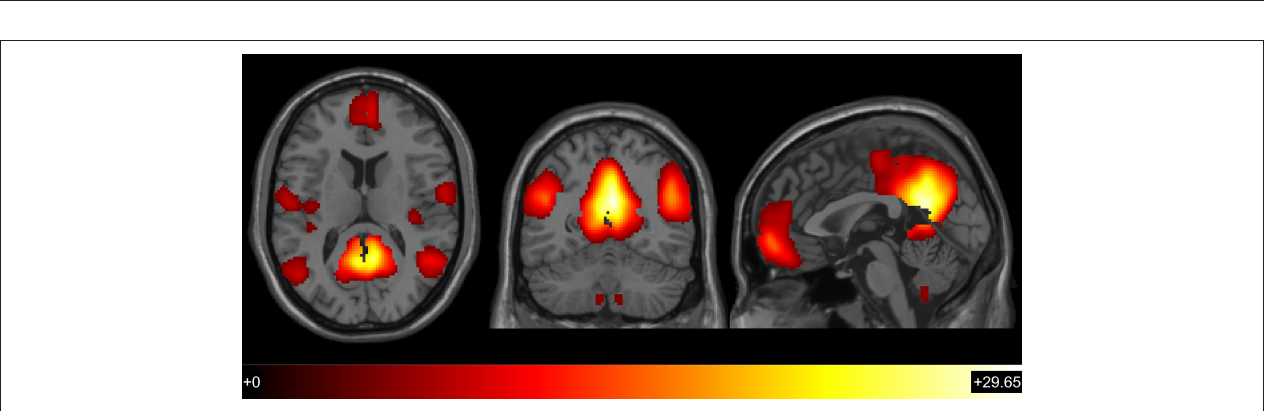
FIGURE 3 | association and cool colors represent a negative association. A positive association between GDS score and metabolic dysfunction or obesity or glucose dysmetabolism was observed in the younger individuals of our sample and became negative at the older ages (B,D,F) . The association between GDS score and lipids imbalance was always positive across the age range (H) . No association between GDS score and blood pressure was observed across the age range (J) . Gender (0 = females; 1 = males), smoking (reference—non-smoker), alcohol consumption (g/day), and physical activity (0 = sedentary; 1 = < 3 times/week; 2 = over 3 times/week). * p < 0.05; ** p < 0.01; *** p < 0.001.